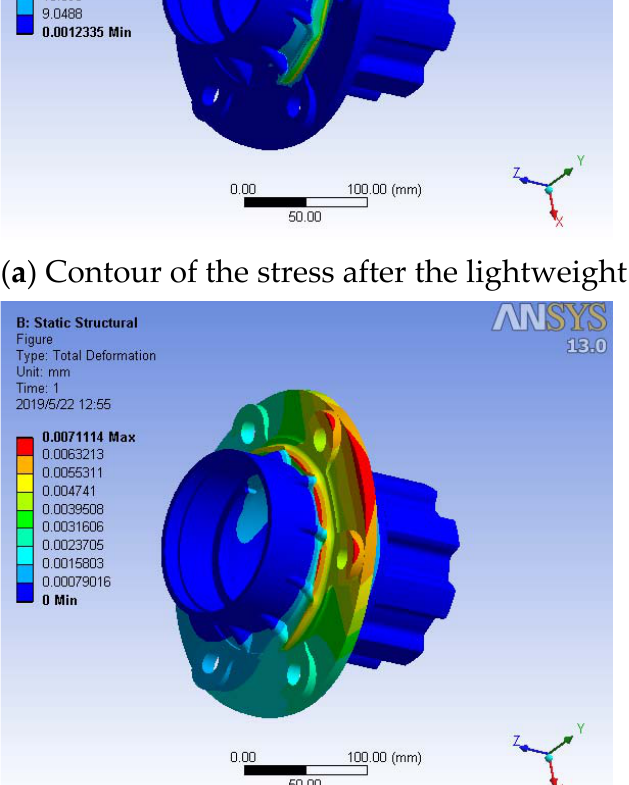
Figure 11. Simulation analysis results of the wheel hub after the lightweight